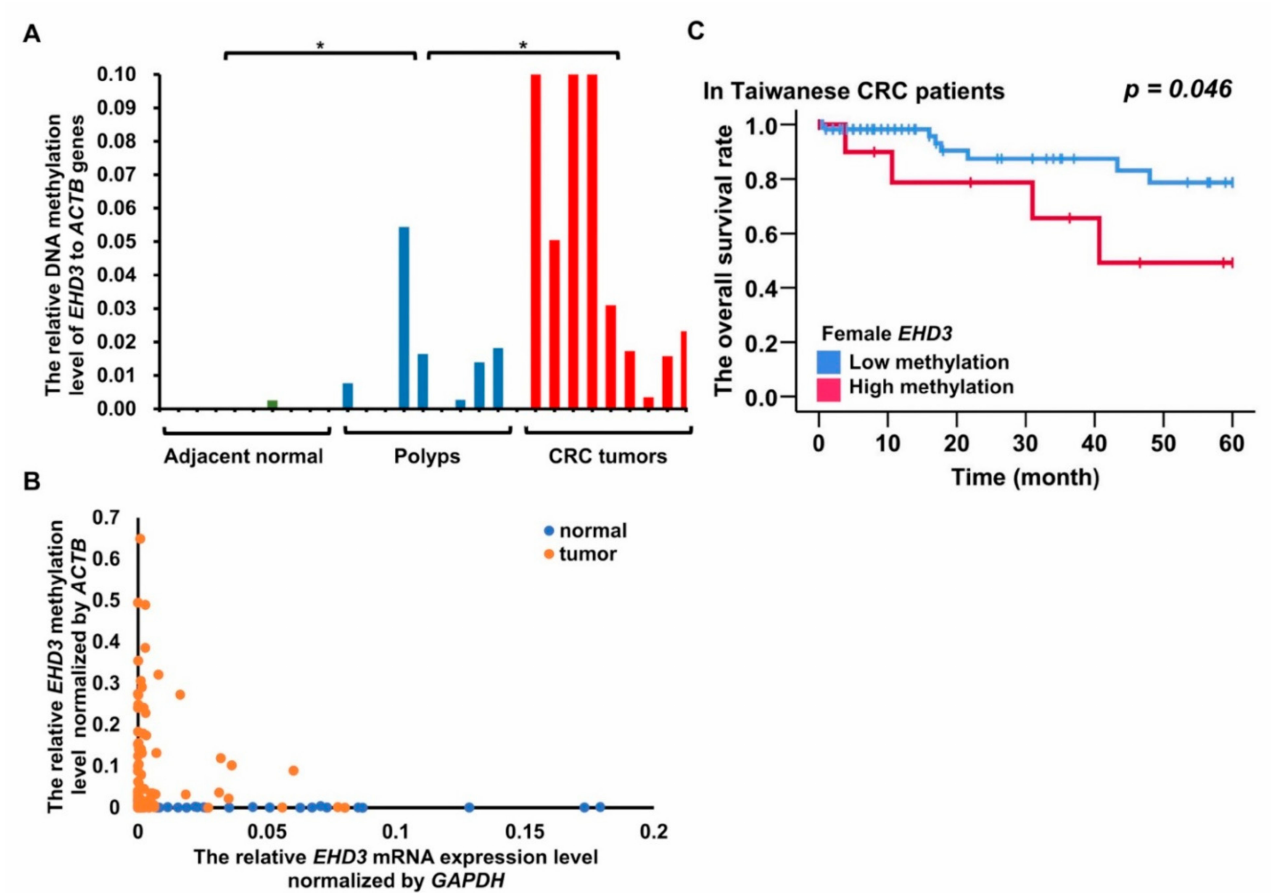
Figure 3. DNA methylation and mRNA expression analysis of EHD3 from an Asian cohort. * p < 0.05. ( A ) EHD3 methylation level in nine adjacent normal colon tissues, nine polyps of tubular adenoma, and nine CRC tumors. The Mann–Whitney U test was used to compare adjacent normal colon tissues and tubular adenoma and to compare tubular adenomas and CRC tumors. ( B ) Spearman’s rank-order correlation was used to estimate the correlation between EHD3 promoter methylation and mRNA expression in the matched normal and tumor tissues. ( C ) The Kaplan–Meier estimate was used to compute the overall survival of women with and without EHD3 hypermethylation. An EHD3 promoter methylation level in CRC tumors 200-fold higher (90th percentile) than that in adjacent normal colorectal tissues was defined as